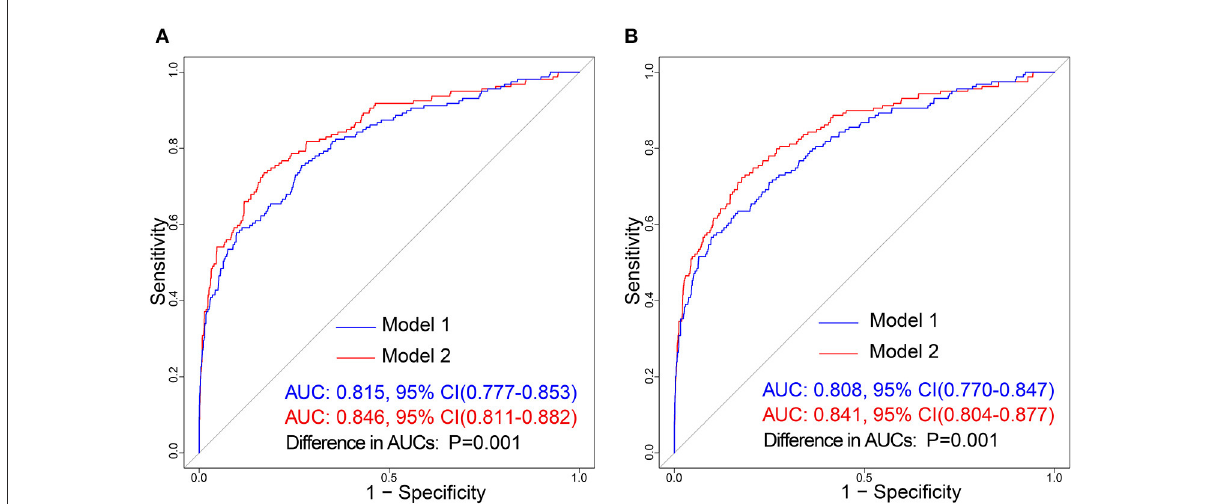
FIGURE6 Receiver operating characteristic (ROC) curve of the prediction models in each cohort. The blue line and red line represent Model 1 and Model 2, respectively. (A) Represents ROC curve of our prediction models in the training cohort; (B) Represents the ROC curve of models in the validation cohort.